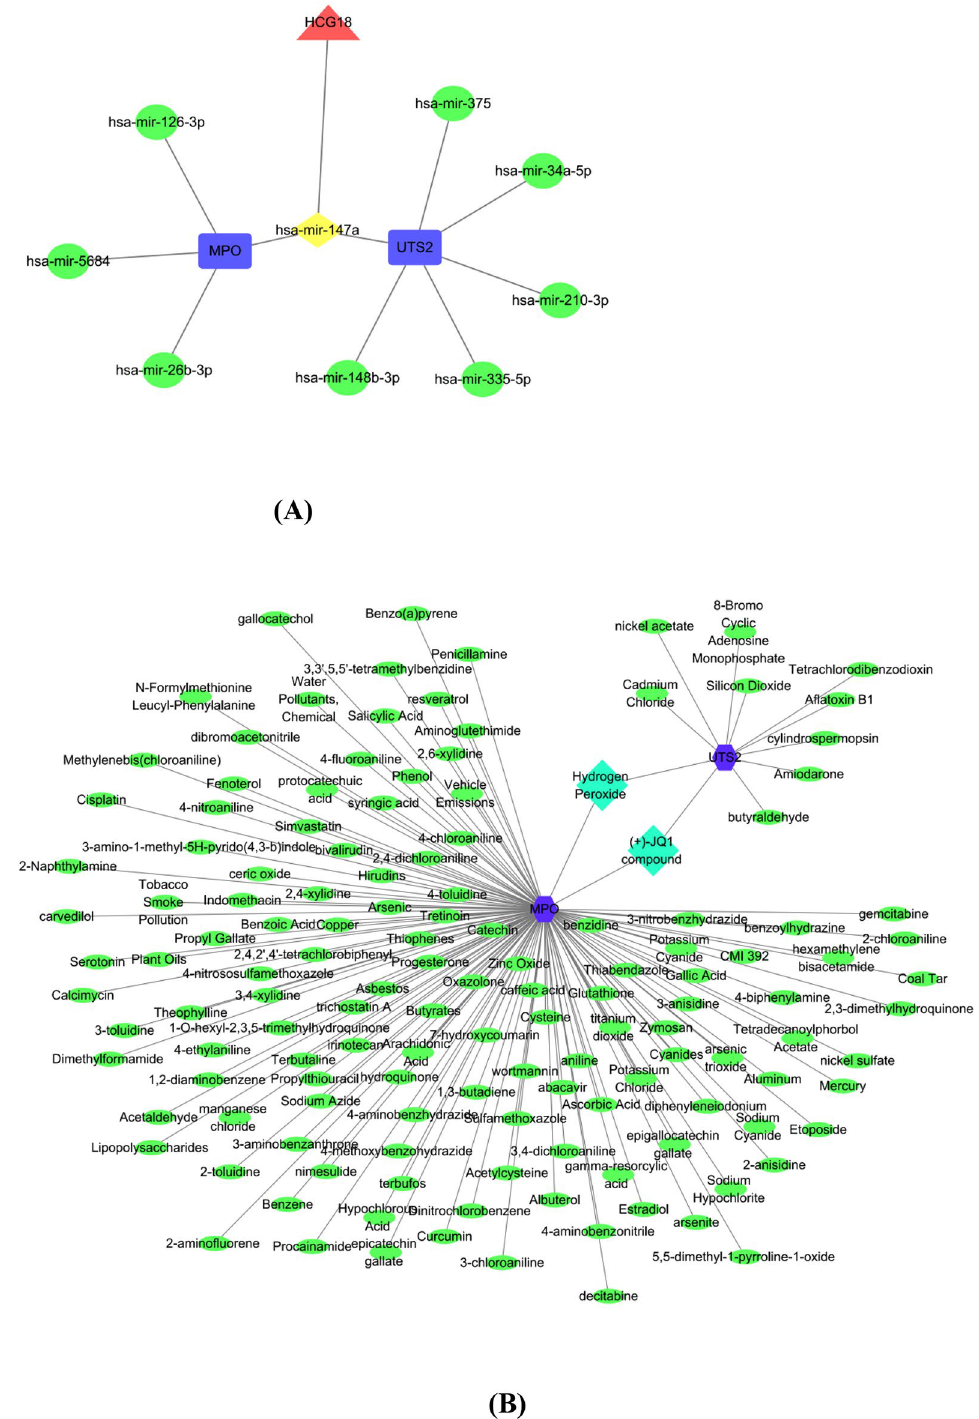
Figure 8. Network analysis of the two CNO-related autoinflammatory genes. ( A ) ceRNA network: An lncRNA is shown in red, miRNAs are shown in green, two mRNAs are shown in blue, and the miRNA common to the two mRNAs is shown in yellow. ( B ) mRNA–chemical interactive network. The two mRNAs are shown in blue, small molecule compounds are shown in green, and the common small molecule compounds common to the two mRNAs are shown in light